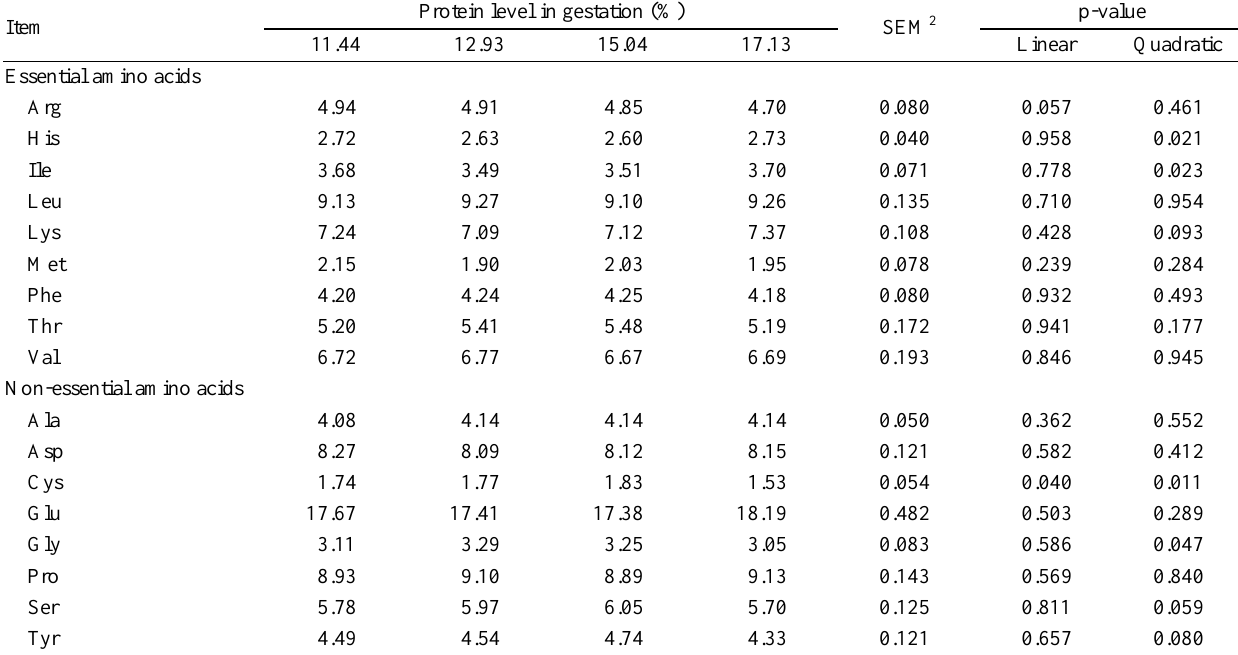
Table 7. Effect of CP levels in gestation diets on amino acid composition (g/100 g milk protein) in colostrum of primiparous sows 1